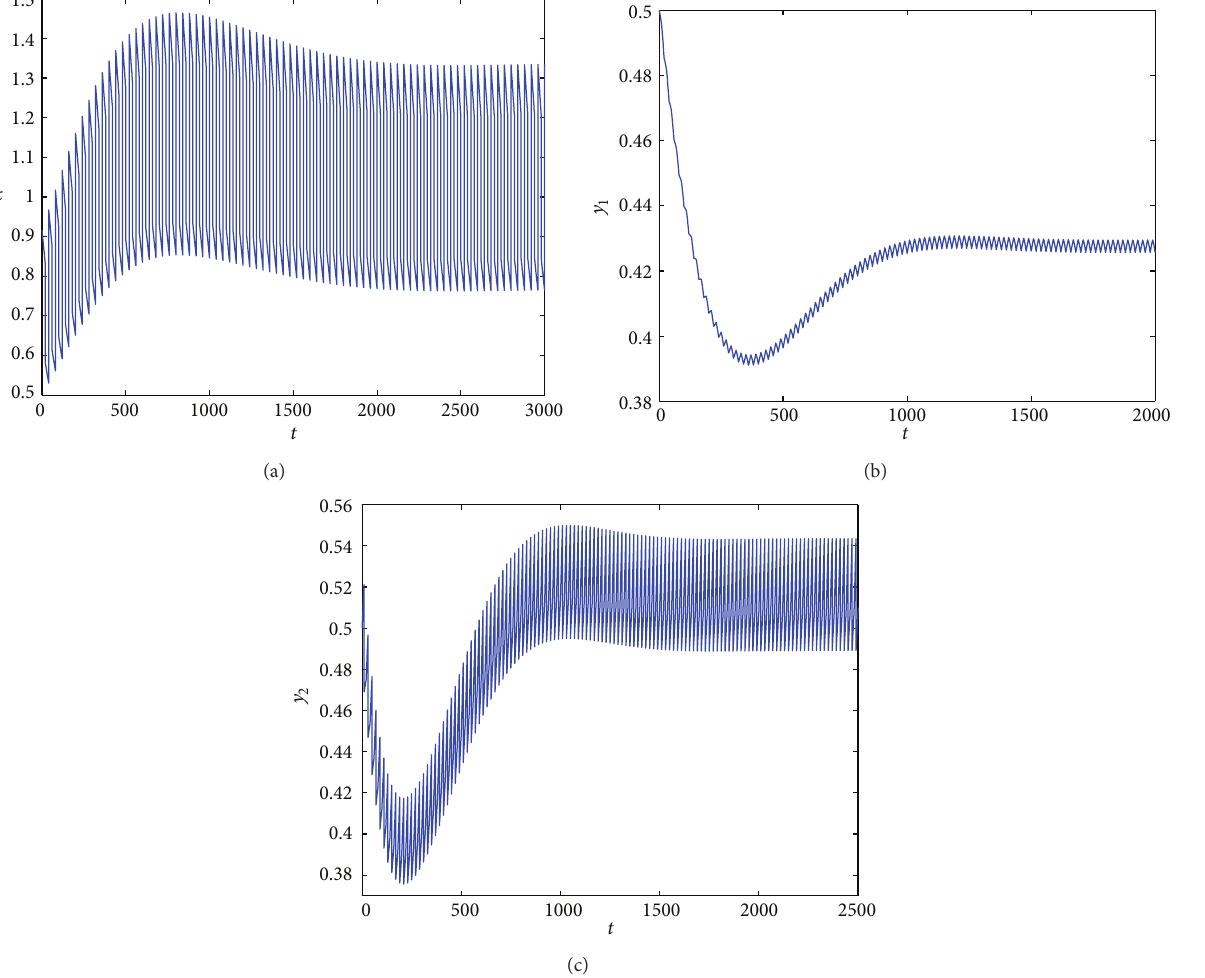
Figure 2: Dynamical behavior of system (4) with 𝑟 = 1 , 𝐾 = 3 , 𝛽 = 2 , 𝑐 = 1 , 𝑑 1 = 0.5 , 𝜆 = 1 , 𝑑 2 = 0.3 , 𝑑 3 = 0.2 , 𝑑 4 = 0.1 , 𝑝 1 = 0.3 , 𝑝 2 = 0.1 , 𝜏 = 1 , 𝑇 = 0.1 . (a) Time series of the prey population; (b) time series of the immature predator population; (c) time series of the mature predator